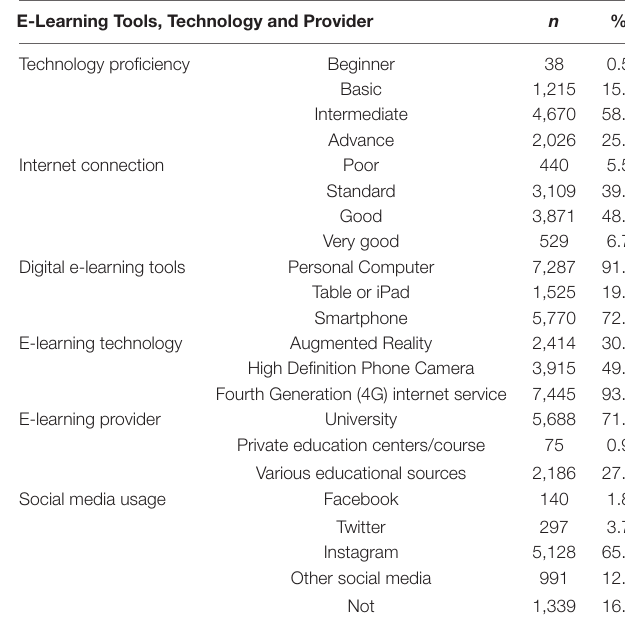
TABLE 2 | E-learning tools, technology and provider during